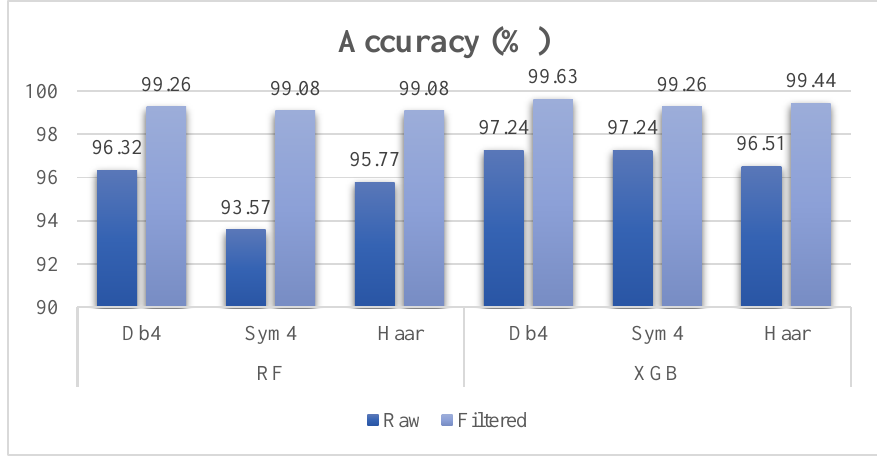
Figure 12. Accuracy for RF and XGB for raw and filtered motor current signals.